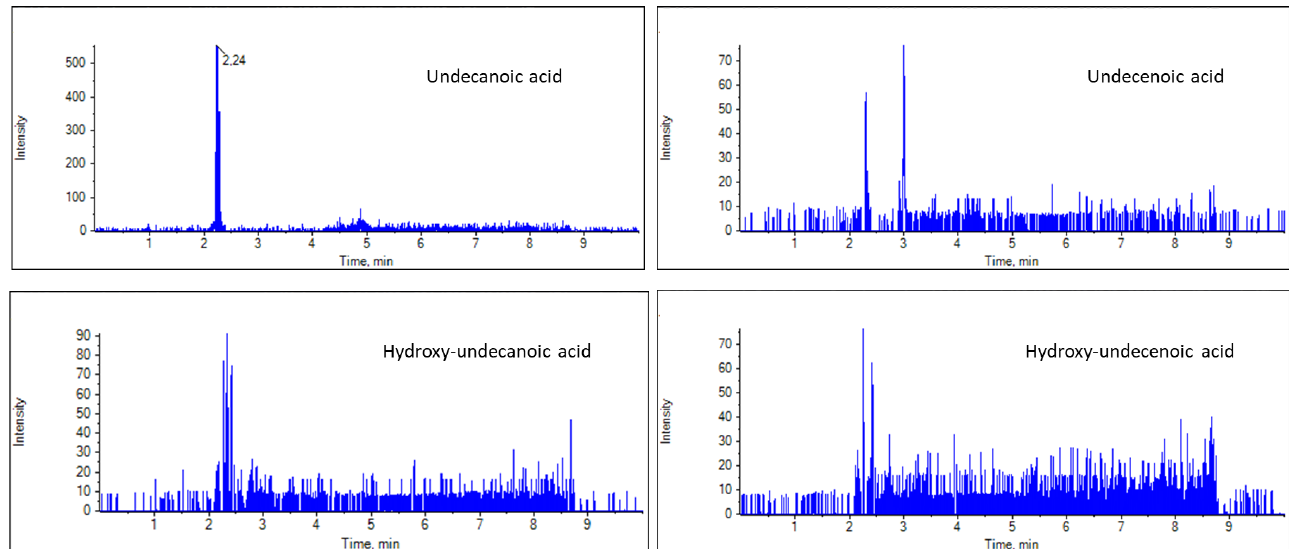
Figure 4. EICs of undecanoic, undecenoic, hydroxyundecanoic and hydroxyundecenoic acids in a representative RJ sample.